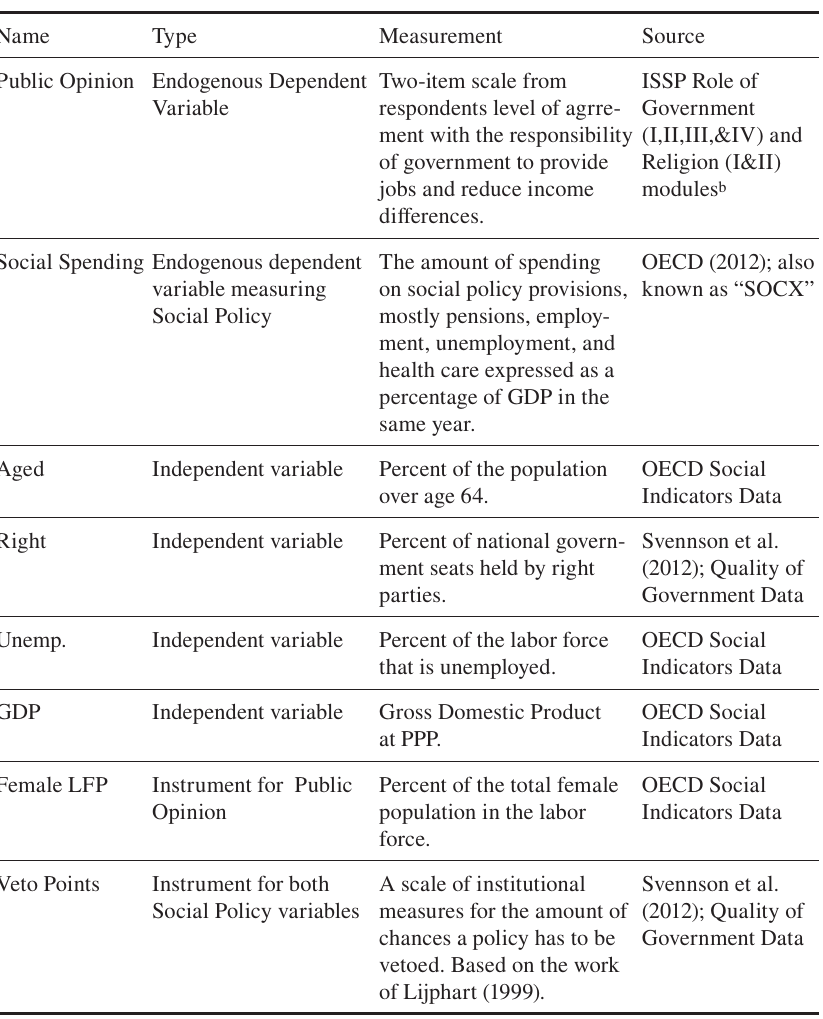
Variable Names and Definitions